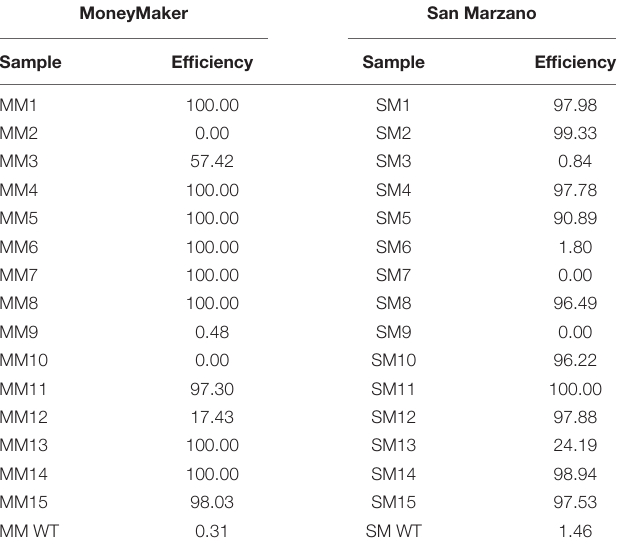
TABLE 1 | Editing efficiencies for the GF target.